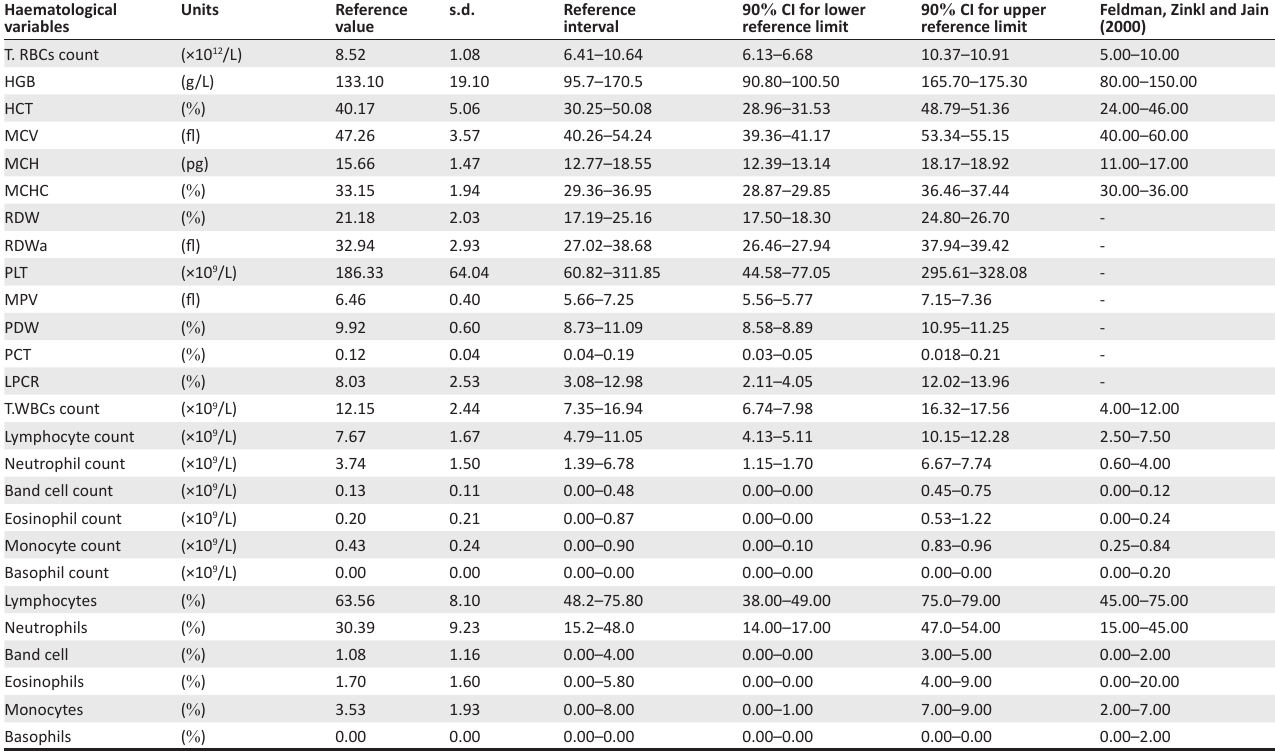
TABLE 5: Reference intervals for haematological variables in buffalo heifers. Haematological